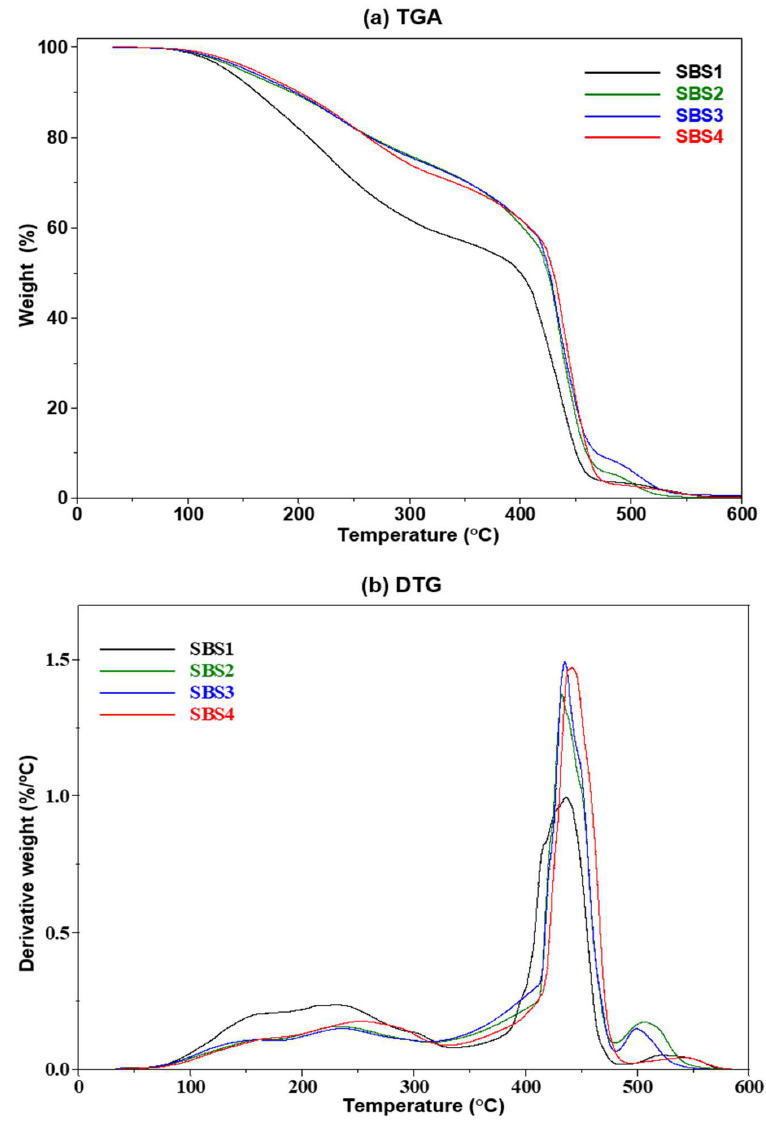
Figure 4. Thermograms of ( a ) TGA and ( b ) DTG of biobased HTPB obtained via metathesis degradation from SBS with 10-undecen-1-ol.